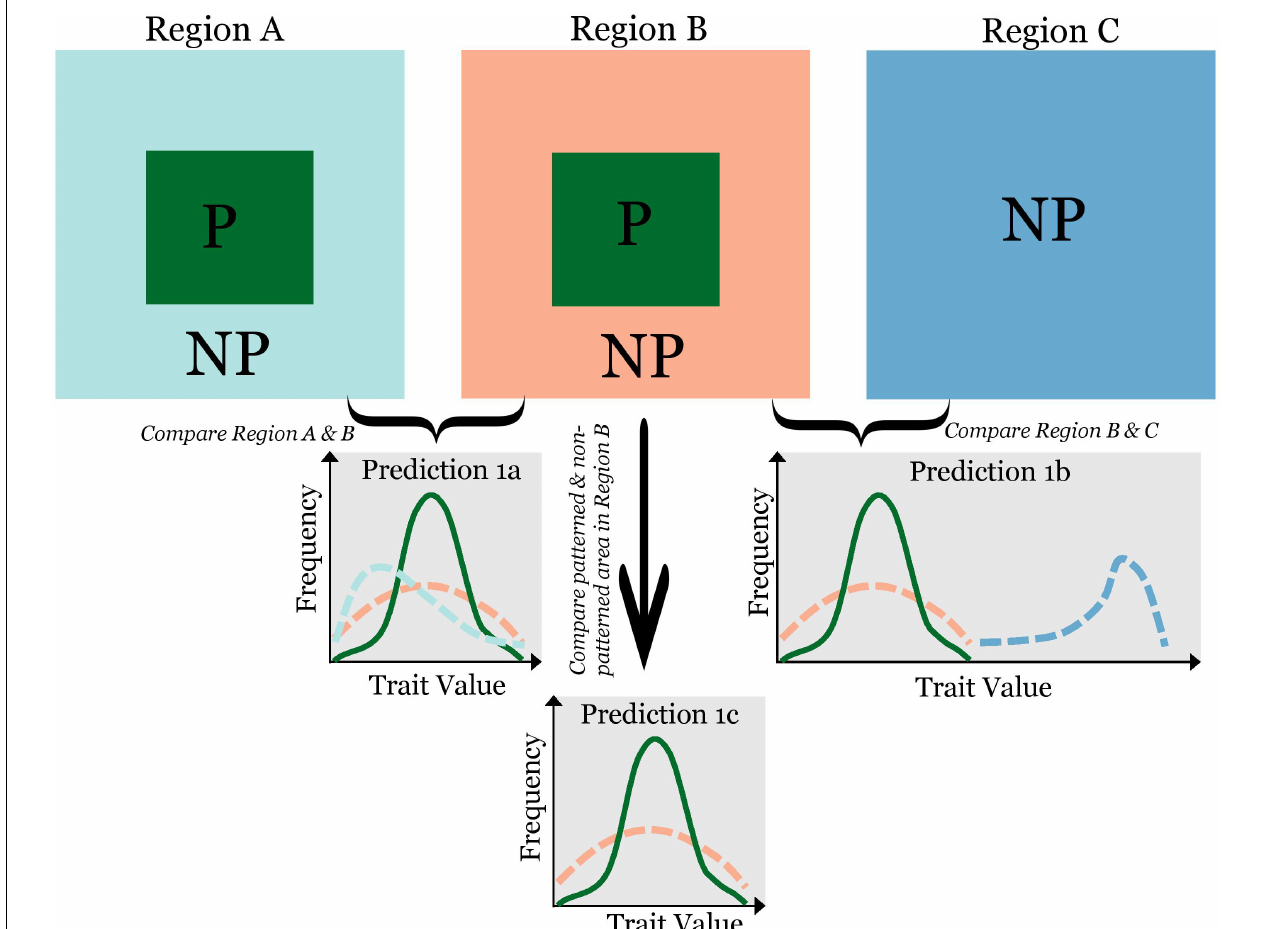
FIGURE 1 | A framework to test hypotheses on the biological constraint of pattern formation using a trait-based approach. “ P ”: patterned and “ NP ”: non-patterned. Solid dark green lines (correspond to the dark-green area of labeled with “ P ” in Region (A,B) show the frequency distribution of a pattern-forming trait within the pattern, and dashed-lines show the frequency distribution of the same trait from the area outside the pattern (the color of lines corresponds to the color of areas). If traits play a role in pattern formation, the following predictions are derived: (1) in two regions that have different trait frequency distributions, we will observe similar frequency distribution of traits from patterned areas in the two regions (Prediction 1a); (2) comparing Region (B,C) , with all environmental conditions the same, but one with regular patterns and another without, we expect the trait distribution in Region (C) to be very different from that in Region (B) (Prediction 1b); and (3) in the same region, we expect the frequency distribution of traits for species within and outside the pattern to be different (Prediction